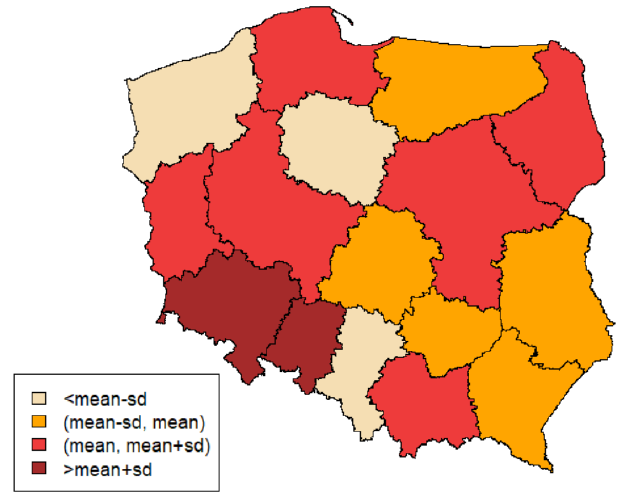
Figure 9. Spatial distribution of residuals with the value of deviations from the mean in the GNS model.